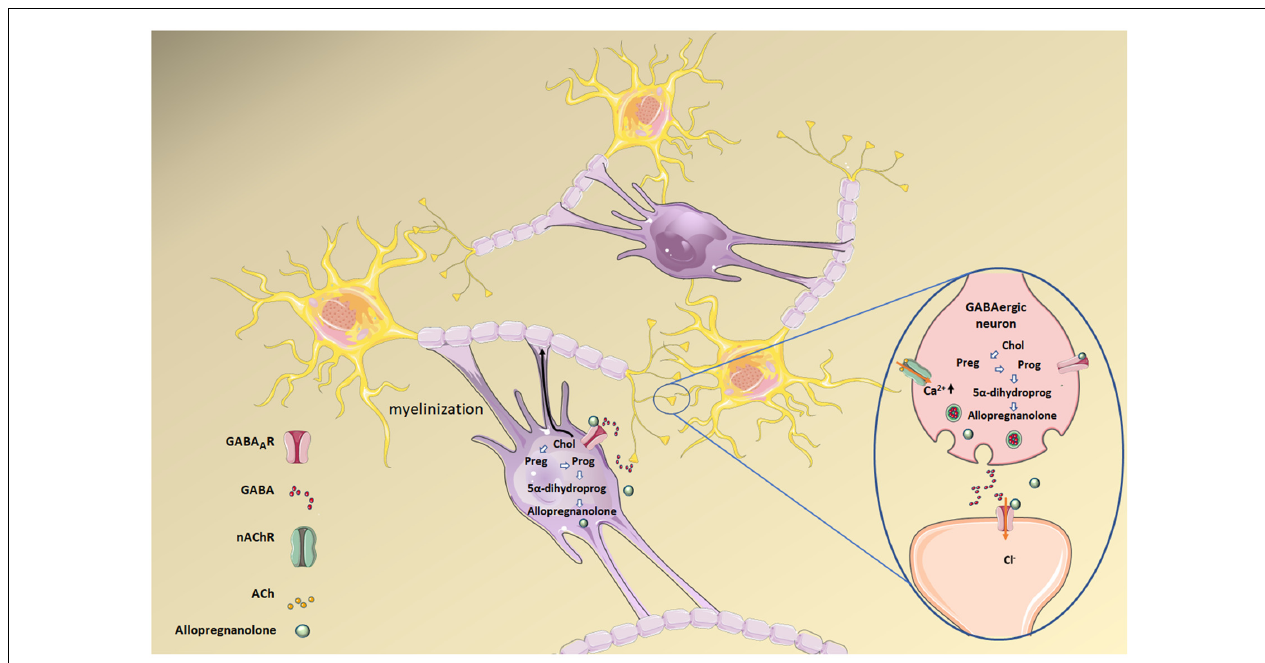
FIGURE 5 | Allopregnanolone synthesis from cholesterol (Chol) in both mature oligodendrocytes (the cells responsible for forming the central myelin) and neurons. Allopregnanolone and other neurosteroids act as transcriptional factors that regulate gene expression upon back-oxidation into 5 α -pregnane steroids, and also modulate neuronal excitability by interacting with neurotransmitter receptors. Allopregnanolone in particular is a positive allosteric modulator of the GABA A R. Preg, pregnenolone; Prog, progesterone; 5 α -dihydroprog, 5 α -dihydroprogesterone. Figure created using Servier Medical Art Commons Attribution 3.0 Unported License (http://smart.servier.com). Servier Medical Art by Servier is licensed under a Creative Commons Attribution 3.0 Unported